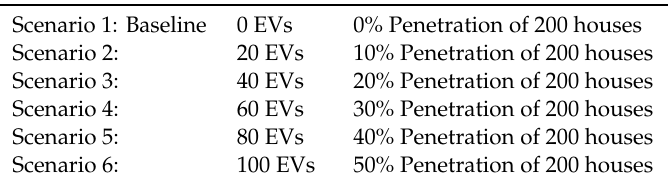
Figure 6. EV State of Charge Estimation [13].